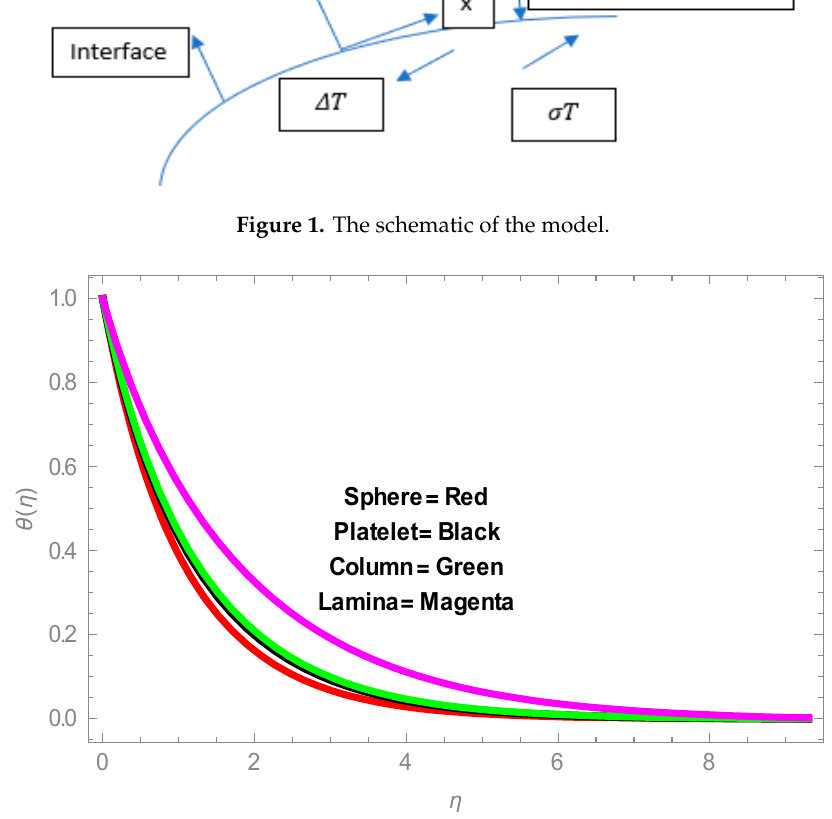
Figure 2. (cid:2016)(η) for shapes of nanoparticles. Figure 2. θ ( η ) for shapes of